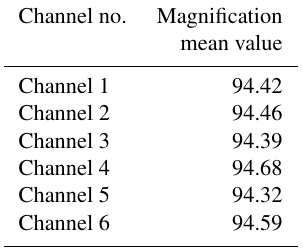
Table 1. Magnification test of six